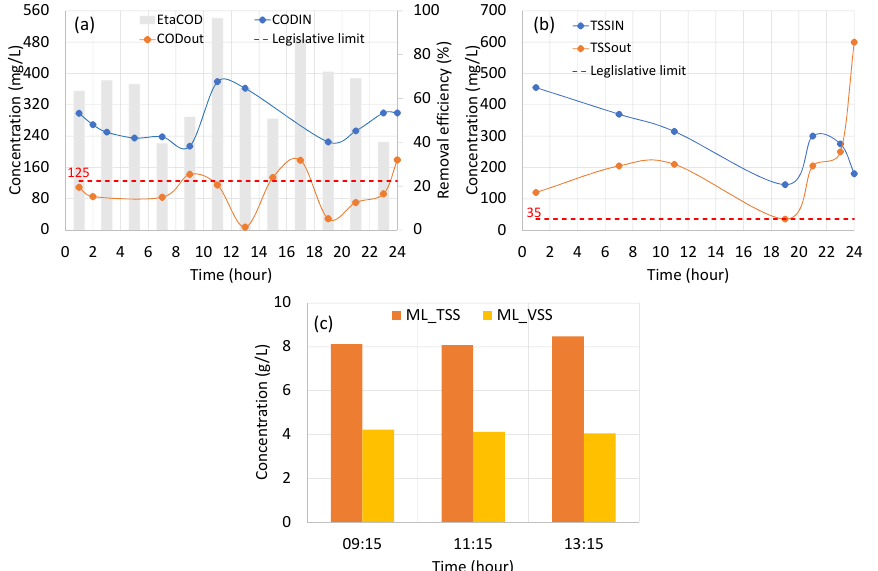
Figure 11. The trend of influent (IN, Section 1) and effluent (out, Section 3) measured the COD, removal efficiency (EtaCOD) and legislative limit ( a ); the trend of influent (IN) and effluent (out) measured the TSS and legislative limit ( b ) and measured the mixed liquor (Section 2) TSS (ML_TSS) and VSS (ML_VSS) ( c ) Marineo WWTP.